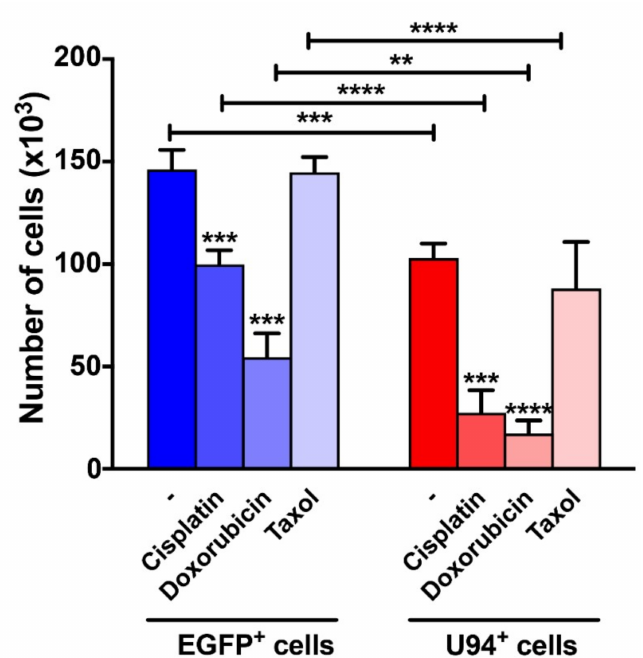
Figure 8. U94 sensitizes cancer cells to DNA-damaging drugs. MDA-MB 231 cells expressing either EGFP (blue bars) or U94 (red bars) were exposed to 100 µ M of cisplatin, 10 µ M of doxorubicin or 50 µ M of docetaxel. Cell proliferation was determined using an automatic cell counter. Values are reported as mean ± SEM of four replicates. ** p < 0.01, *** p < 0.001 and **** p < 0.0001 by Two-way ANOVA followed by Sidak’s multiple comparison